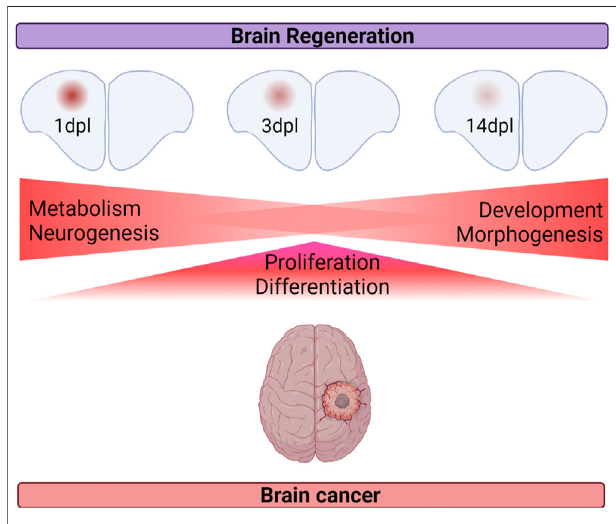
FIGURE 8 | Summary of the shared cellular mechanisms between brain regeneration at three different stages of regeneration and brain cancer.